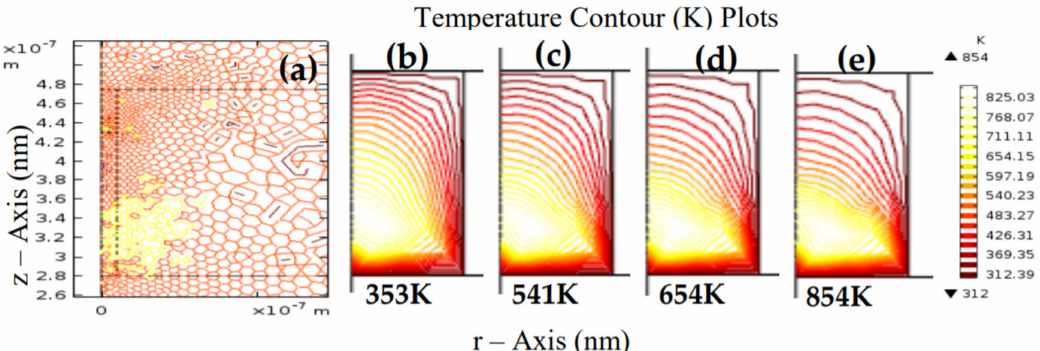
Figure 7. Thermal energy due to Joule heating showing: ( a ) initial ambient temperature, ( b ) the first temperature rise, ( c ) temperature rise during CF growth at 541 K, ( d ) temperature rise at 654 K, and ( e ) temperature rise at 854 K. The device’s temperature rise is due to the current flowing through the radially developed CF; the material gains thermal energy due to Joule